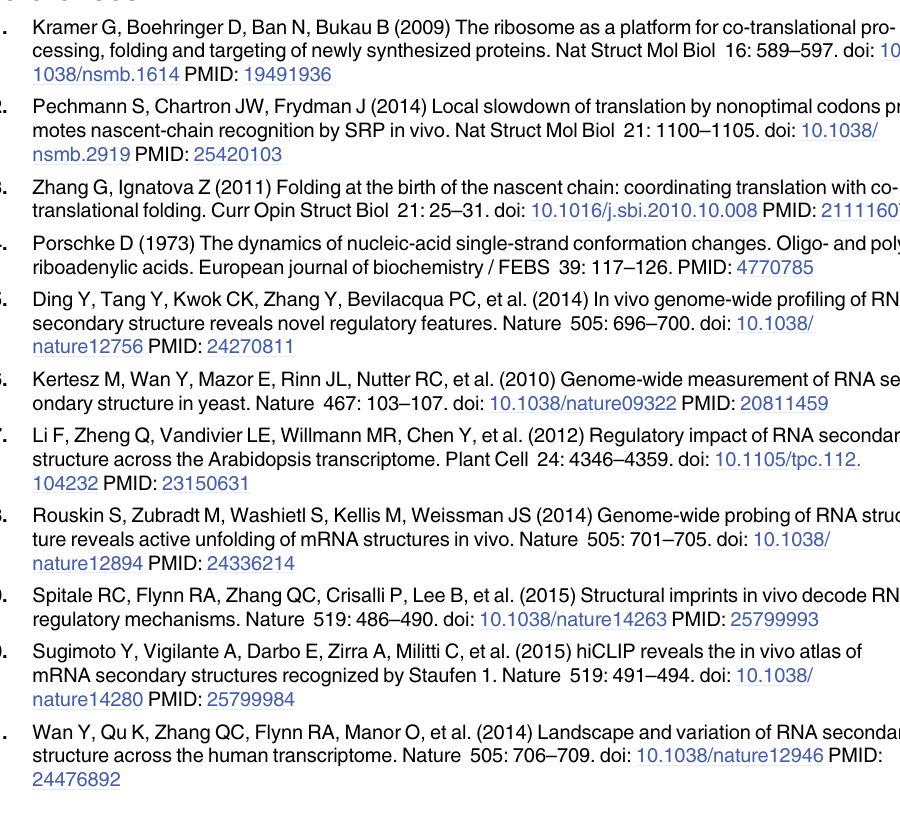
S1 Table. List of genes with identified ribosomal stalling induced by mRNA secondary structure. Green, membrane proteins; blue, ribosomal proteins; orange, cytosolic proteins. S2 Table. List of the 64 RNase E cleavage positions. Positions denote the gene coordinates in the E . coli chromosome on either the forward (fwd) or reverse (rvs)